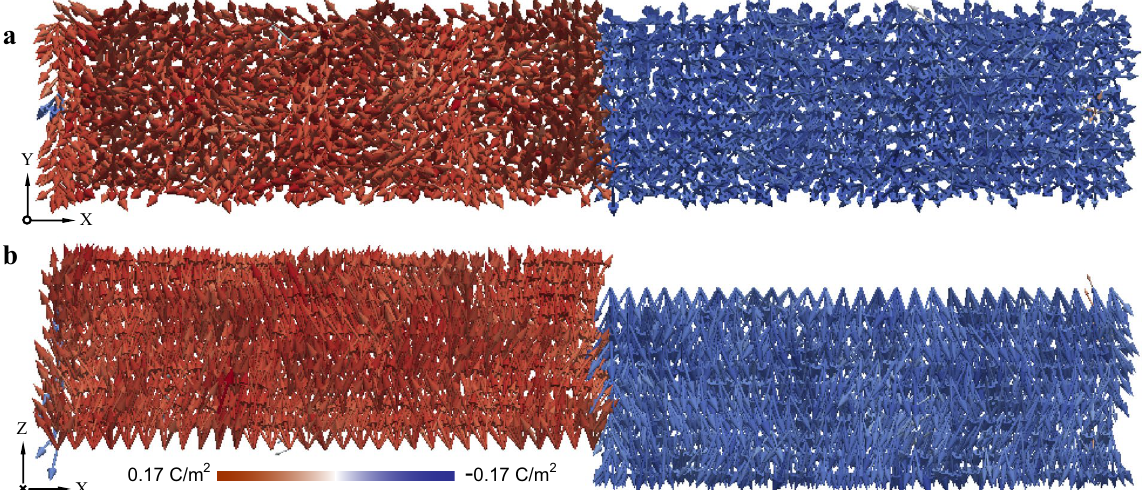
Figure 2. Polarization of unit cells after equilibration of uncharged anti-parallel domains. Each arrow represents polarisation of a single unit cell inside the fully equilibrated, periodic 60 × 10 × 10 supercell system. Arrows in red and blue indicate a positive Z component and a negative Z component, respectively. ( a and b) , parallel projection of polarisation arrows onto the XY and the XZ plane, respectively.